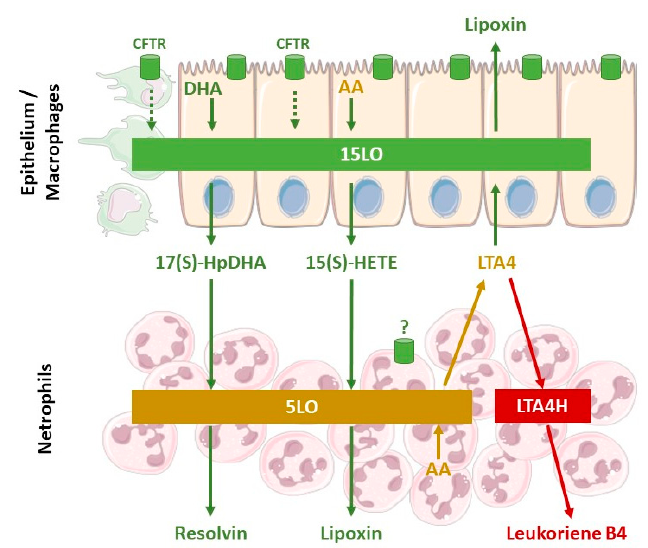
Figure 2. Schematic view of specialized pro-resolving eicosanoid mediators (SPM) biosynthesis pathways. Lipoxin and resolvin result from lipoxygenases interactions. Transcellular biosynthesis can occur via the interactions of two or more cell types expressing different enzymes. Epithelial cells and macrophages express the 15-lipoxygenase (15LO), that metabolizes docosahexaenoic acid (DHA) and arachidonic acid (AA) to produce 17(S)-HpDHA and 15-Hydroxyeicosatetraenoic acid (15(S)-HETE), respectively. These products of 15LO activity are the substrates for the 5LO expressed in neutrophils, to synthetize resolvin and lipoxin (pro-resolving mediators). The 5LO can also metabolize AA into leukotriene A4 (LTA4), which can be substrate of both, the 15LO to produce lipoxin or the LTA4H to produce leukotriene B4 (pro-inflammatory mediator). The pro-resolving pathways are illustrated in green, the pro-inflammatory pathway in red, and enzyme/product/substrate involved in both pathways in brown. The precise mechanism by which CFTR could affect LO activity is not known (green dotted arrow).